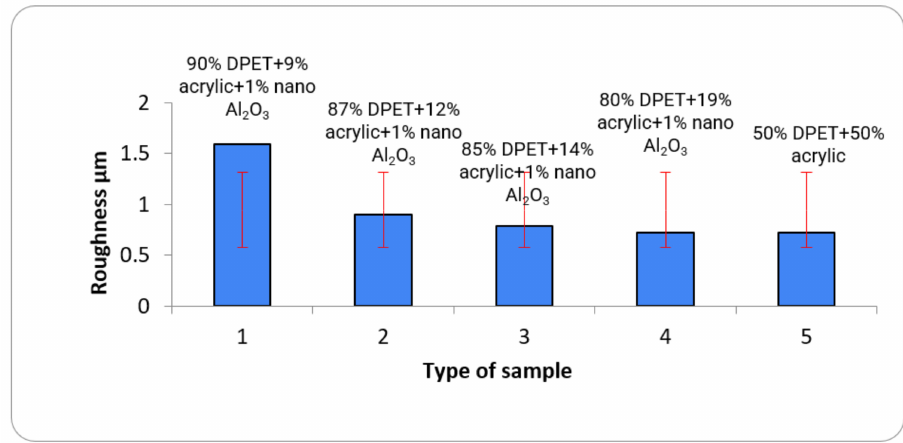
Figure 3. Surface roughness of the composite coating (DPET + PMMA with nanoAl 2 O 3